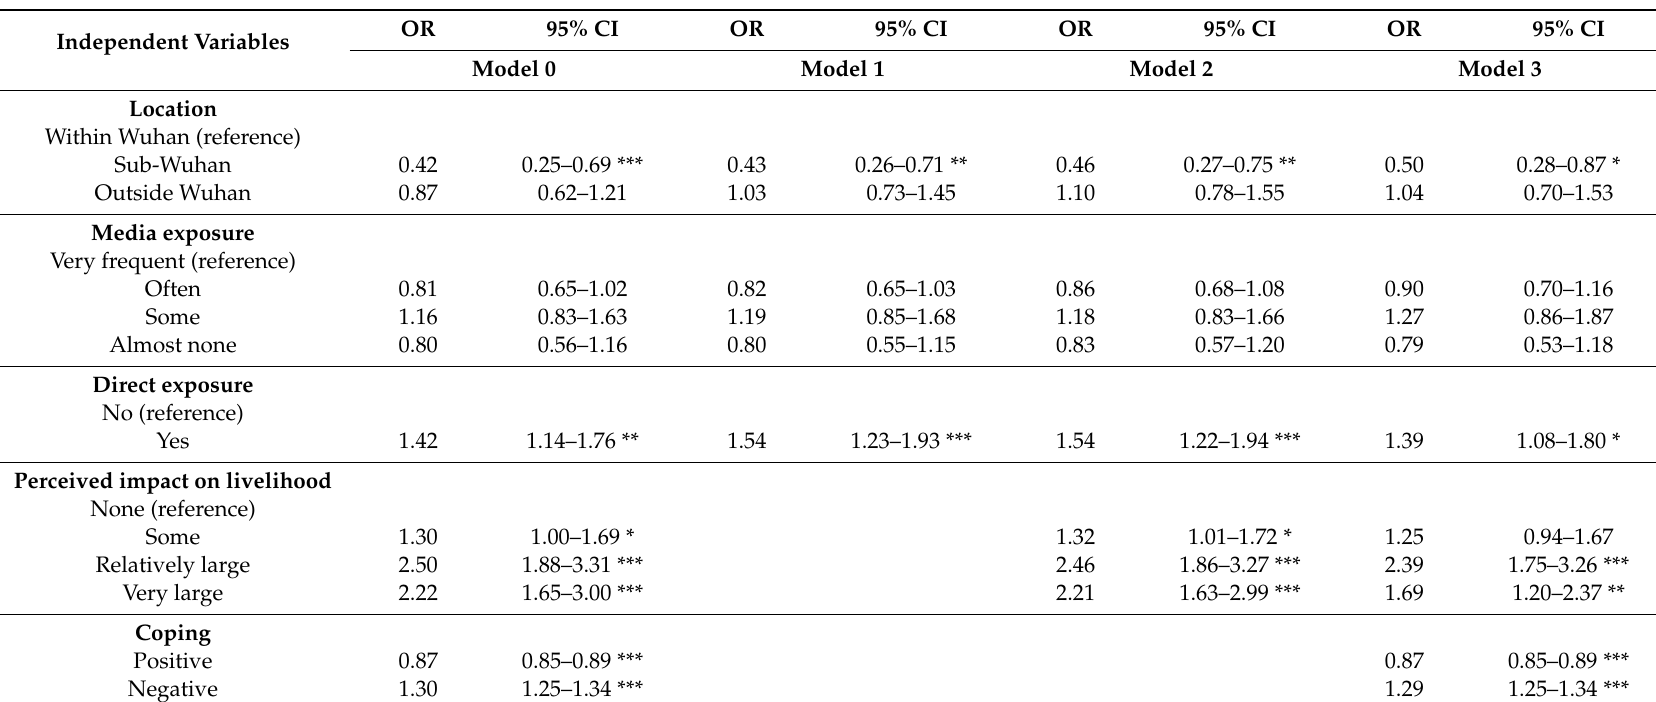
Table 4. Binary logistic regressions with exposure and coping style predicting